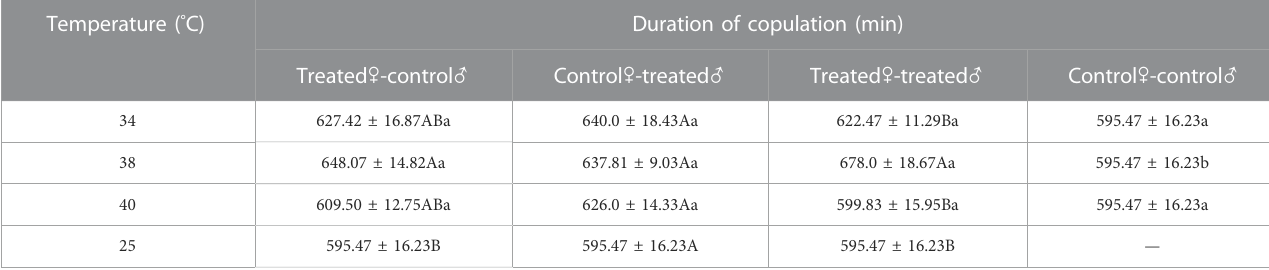
TABLE 4 The duration of copulation of Z. tau adults exposed to different short-term high-temperature treatments for 12 h. Temperature ( ° C)